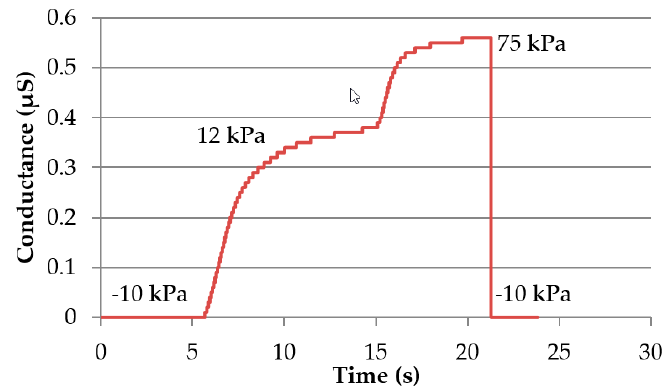
Figure 8. Pressure-dependent conductance on skin of the screen-printed electrode module on one subject (Data from [21]).